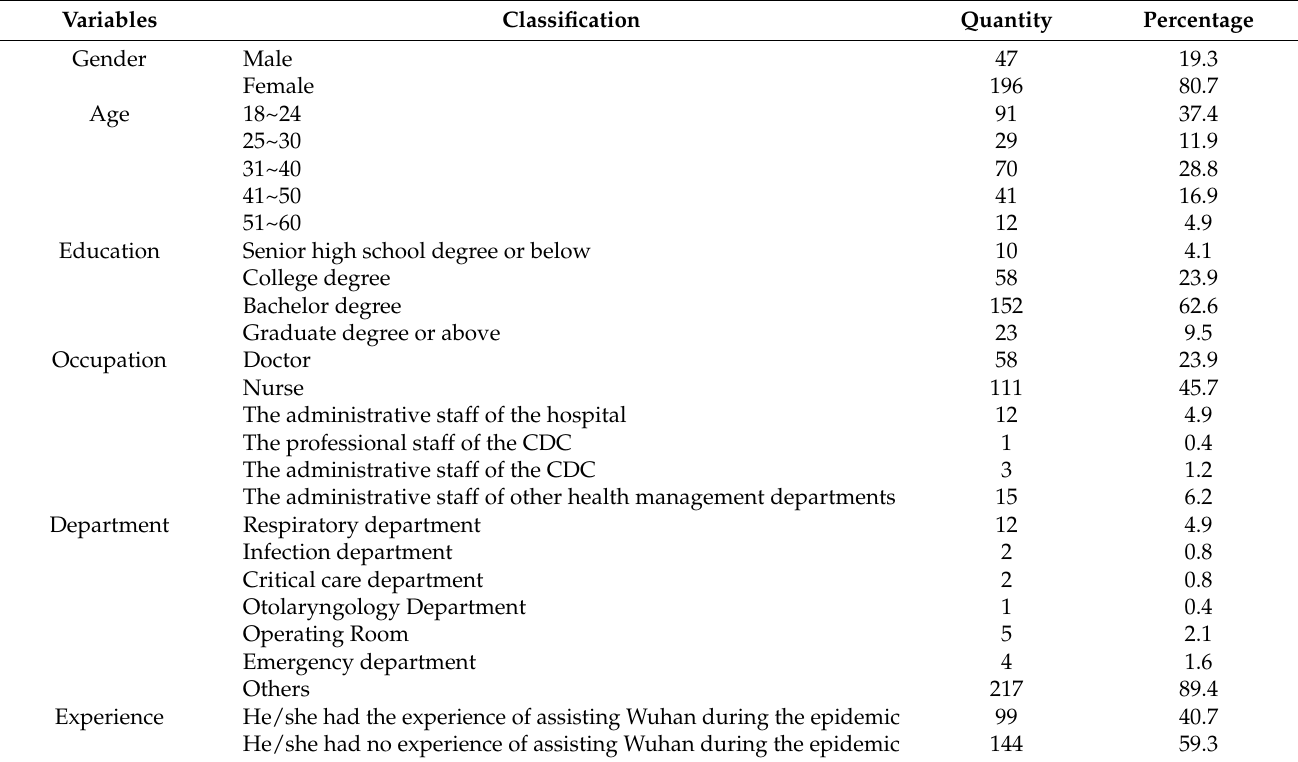
Table 2. Distribution of demographic characteristics of